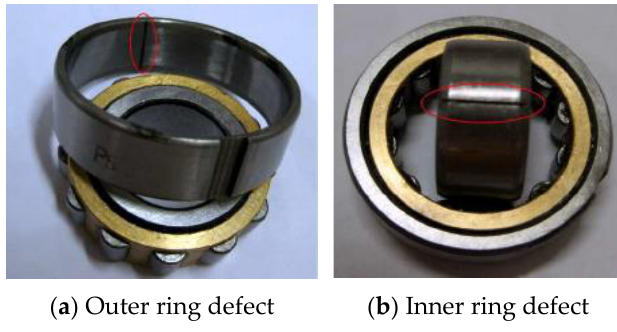
Figure 11. Physical type of rolling gear failure.